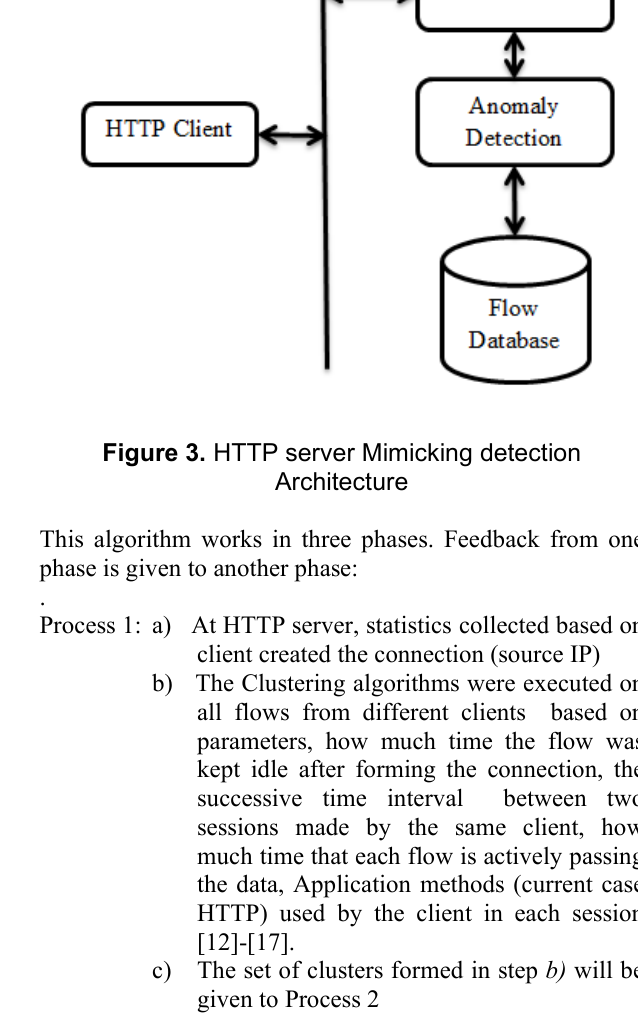
Figure 1. Mimicking attack Architecture